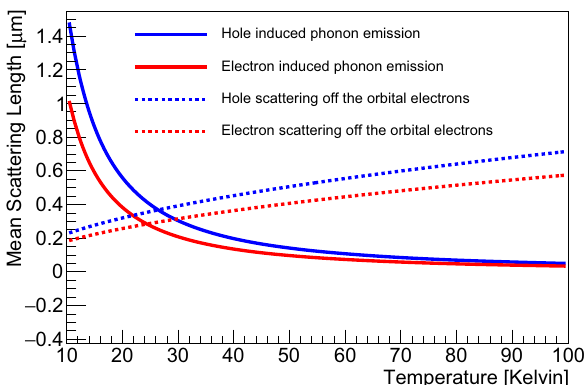
Fig. 3 The mean scattering length versus temperature for charge carri- ers scattering off the orbital electrons and charge carriers scattering off the lattice, respectively at zero electric field. The solid lines represent hole/electron scattering with the lattice leading to phonon emissions, while the dotted lines stand for scattering with orbital electrons leading to ionization